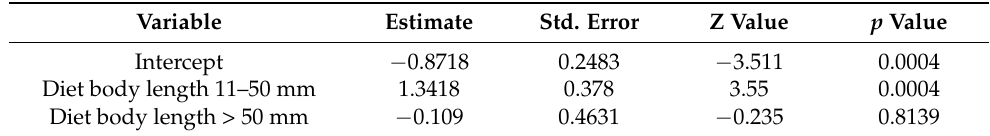
Table 3. Results of model explaining the significant factor related to waterbird global population trends in Southern Africa.